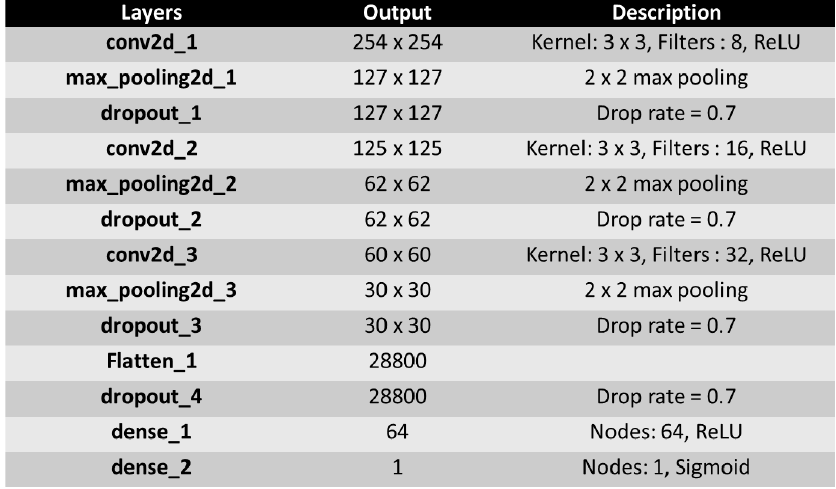
Figure 4. The selected CNN architecture for diagnosis of metastatic breast cancer in bones.